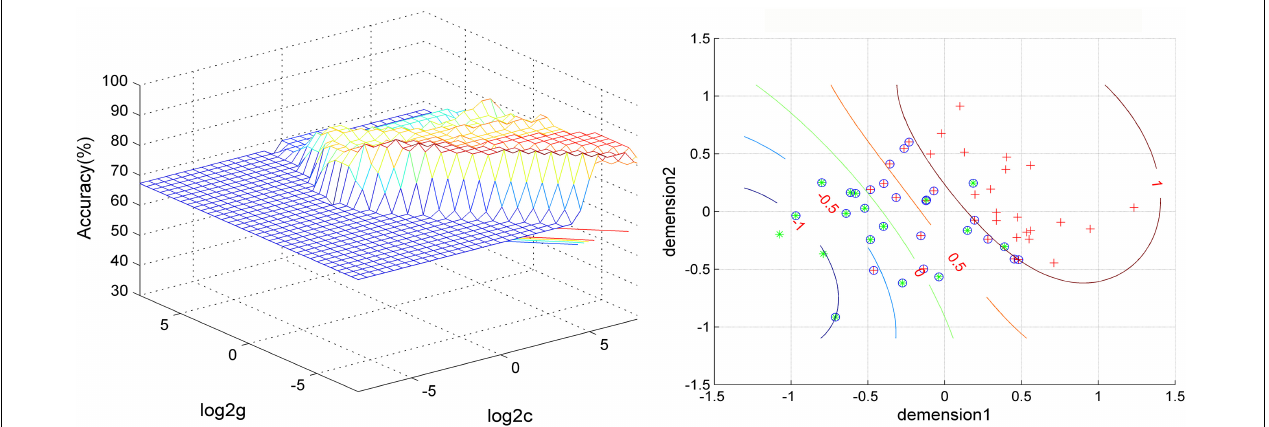
FIGURE 4 | Visualization of classifications through support vector machine (SVM) using a combination of NH values in the right precuneus and right middle temporal gyrus. Left: SVM parameters result of 3D view. Right: dimension 1 and dimension 2 represent the NH values in the right precuneus and right middle temporal gyrus, respectively. Red crosses represent MDD patients with GI symptoms, and green crosses represent MDD patients without GI symptoms. The circles mean support vectors. MDD, major depressive disorder; GI, gastrointestinal symptoms.